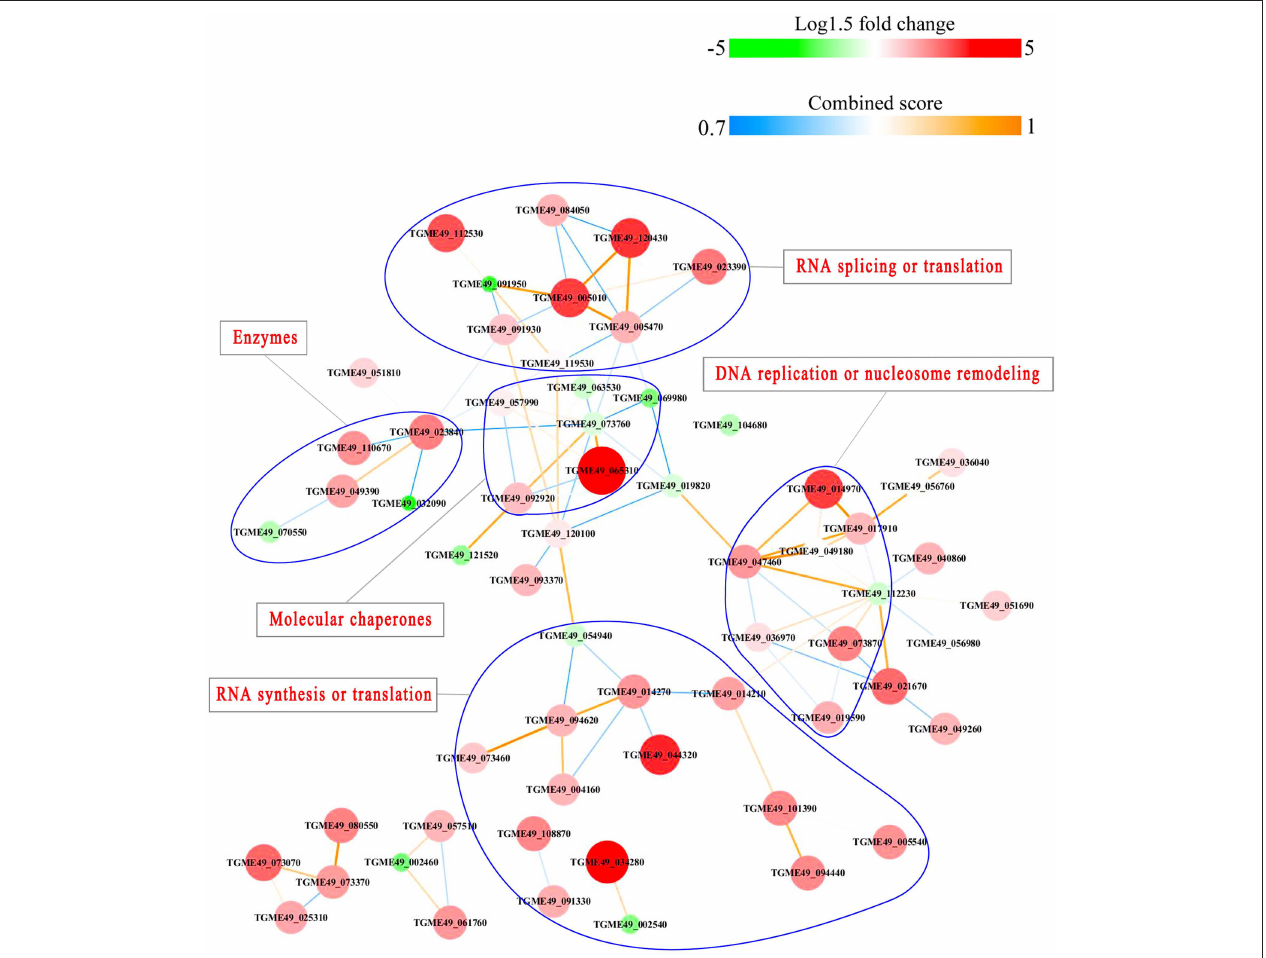
FIGURE 10 | Interaction network (combined score > 0.7) of the identified phosphoproteins up/down-regulated in RH strain when comparing RH/PRU strains. The nodes represent phosphoproteins and the edges denote interactors between phosphoproteins. The upregulation and downregulation of phosphoproteins were characterized by the color and size of nodes. Red and large size nodes denote up-regulated phosphoproteins in RH, whereas green and small size nodes indicate down-regulated phosphoproteins in RH. The color of edge represents the combined score of